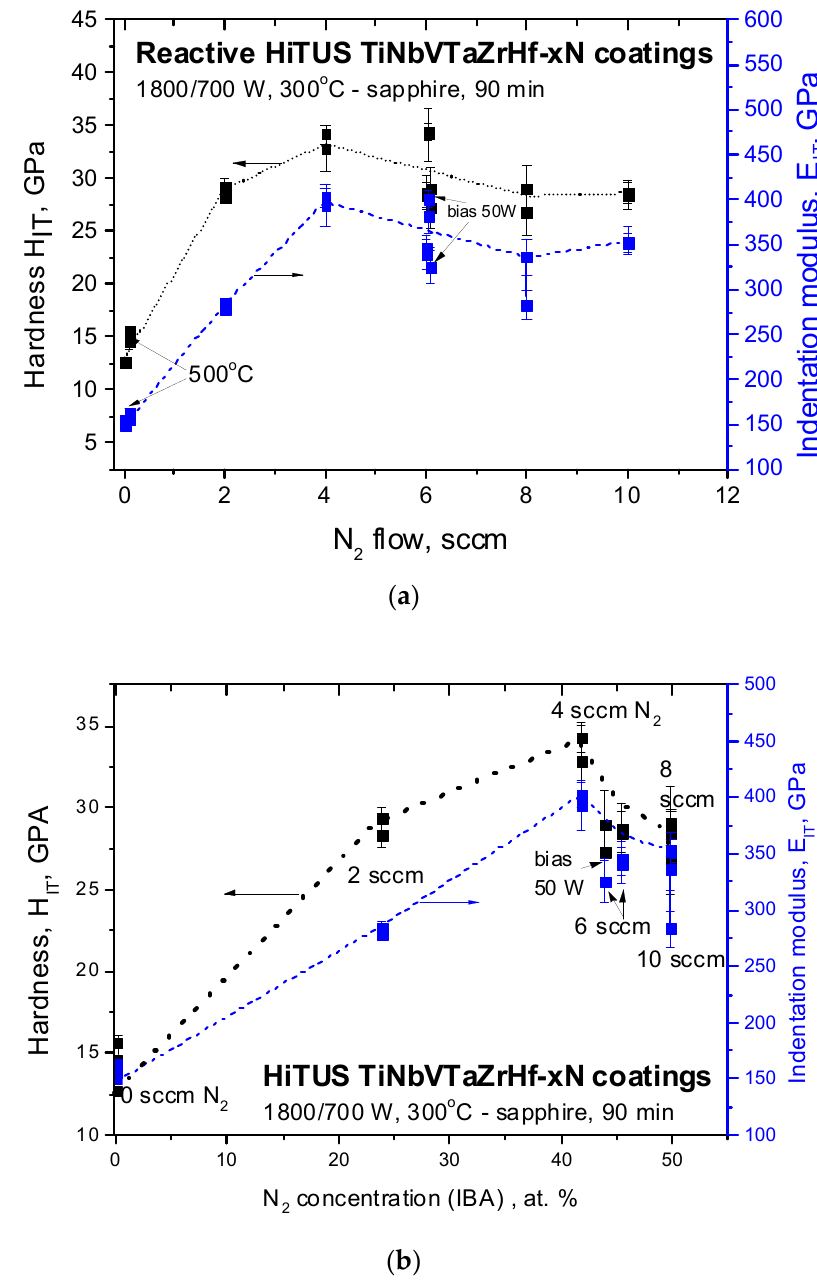
Figure 13. The dependences of hardness and indentation modulus in the studied reactive HiTUS TiNbVTaZrHf-xN coatings on ( a ) nitrogen flow in Ar sputtering atmosphere and ( b ) IBA nitrogen concentrations.